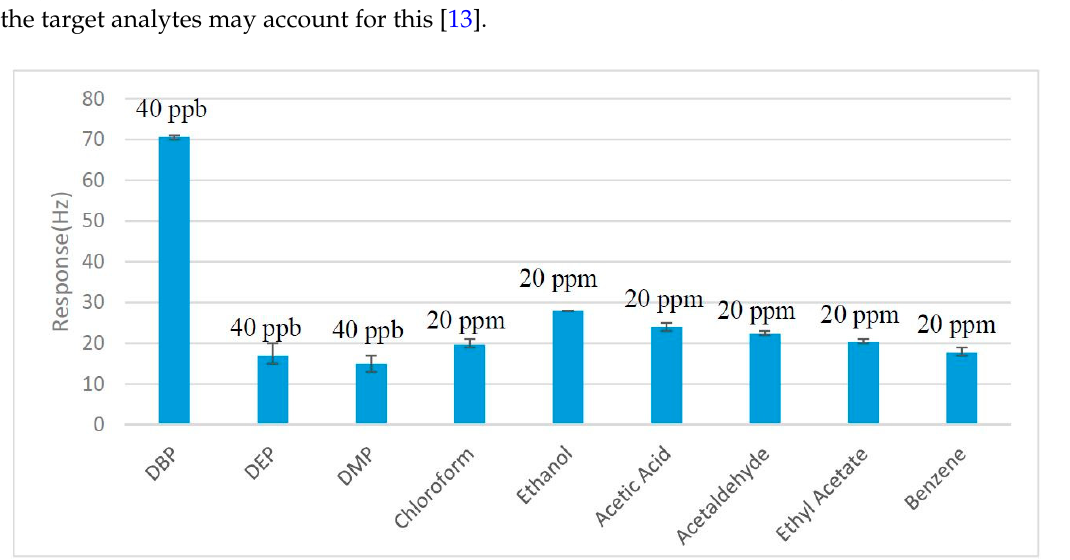
Figure 4. Responses of the nano-Ni(OH) 2 QCM sensor to various organic vapors. The concentration of DBP, diethyl phthalate (DEP) and dimethyl phthalate (DMP) was 40 ppb, while other vapors were 20 ppm. The response of DBP was far bigger than the